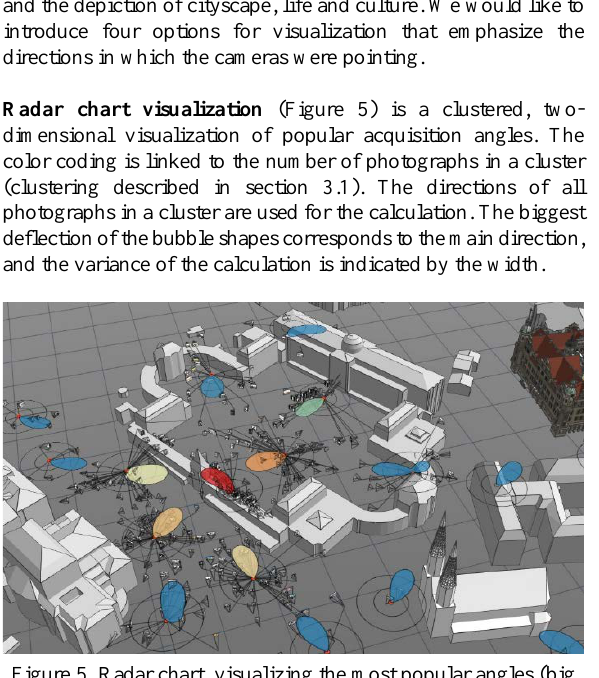
Figure 5. Radar chart, visualizing the most popular angles (big deflection of bubble shapes) of photographs Radial fan visualization (Figure 6) is similar to the radar chart. The full 360° circle around the center of a cluster is evenly divided into 16 segments. All images with a direction that corresponds to a segments are used to calculate the size of a segment. The longest segment indicates the main direction. The color coding corresponds to the size of the segments.